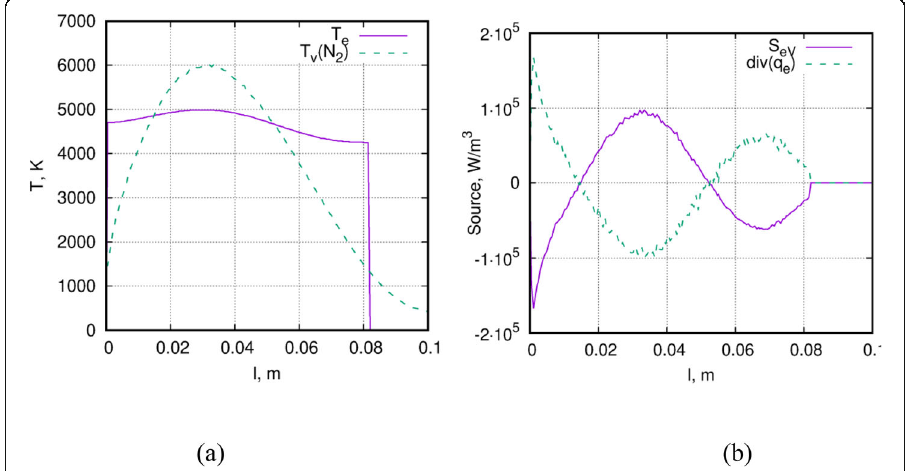
Fig. 6 Electron temperature and vibrational temperature ( а ); profile of S eV and heat flux divergence ( b ) along the line indicated in Fig.